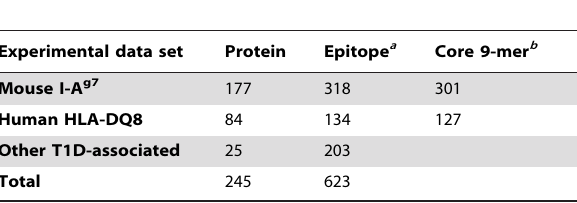
Table 1. The statistical data on the experimentally validated epitopes collected in this